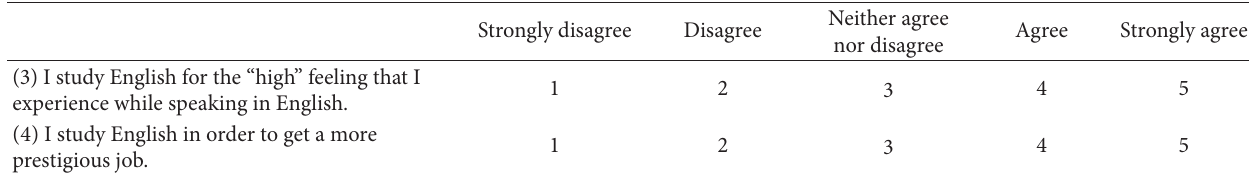
Table 1: Two example items of the Motivation Questionnaire.